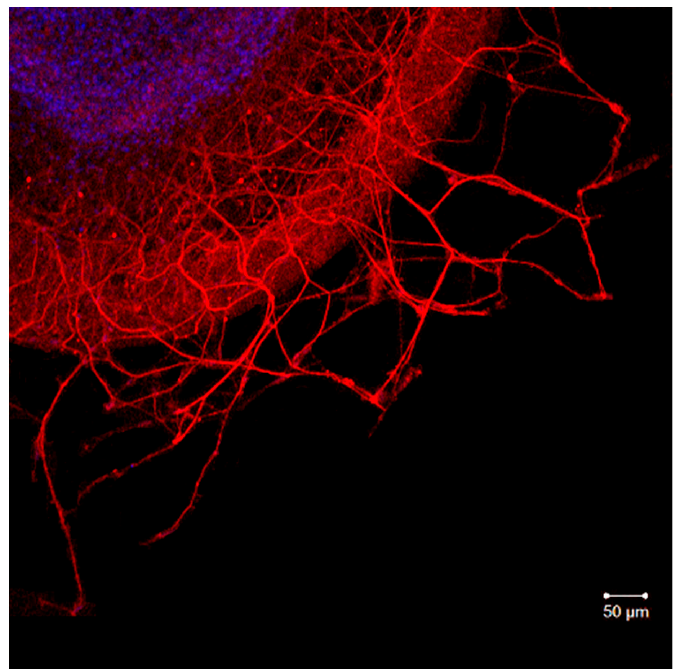
Figure 6. Fragment of DRG explant growth zone (third day of culturing). DRG explant is labeled with anti-neurofilament 200 antibody (red), while DAPI (blue) is used to visualize the cell’s nuclei. Control. Scale bar 50 µ m.